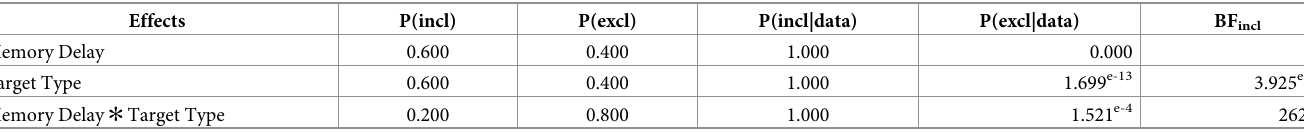
Table 3. Follow-up ANOVA for illusory error-rates.